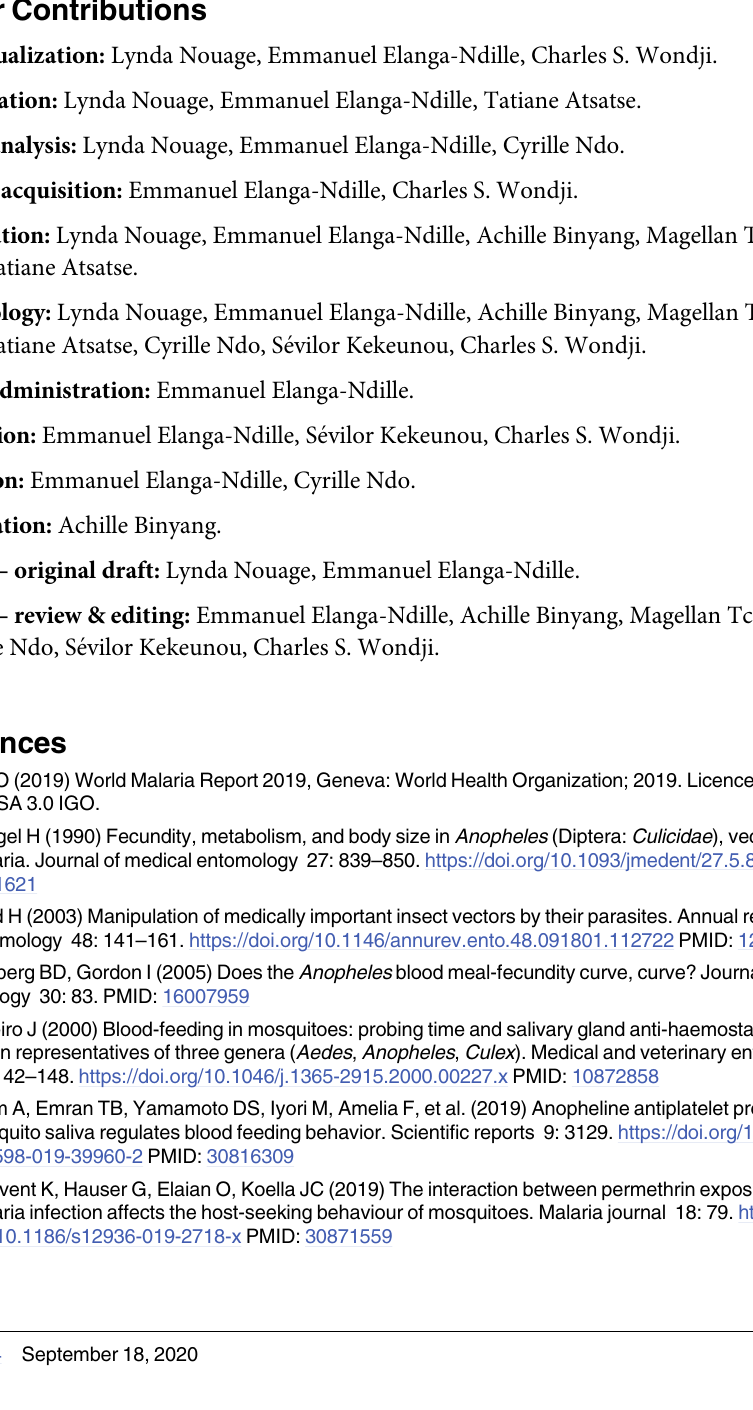
S1 Table. List of primers used for qPCR